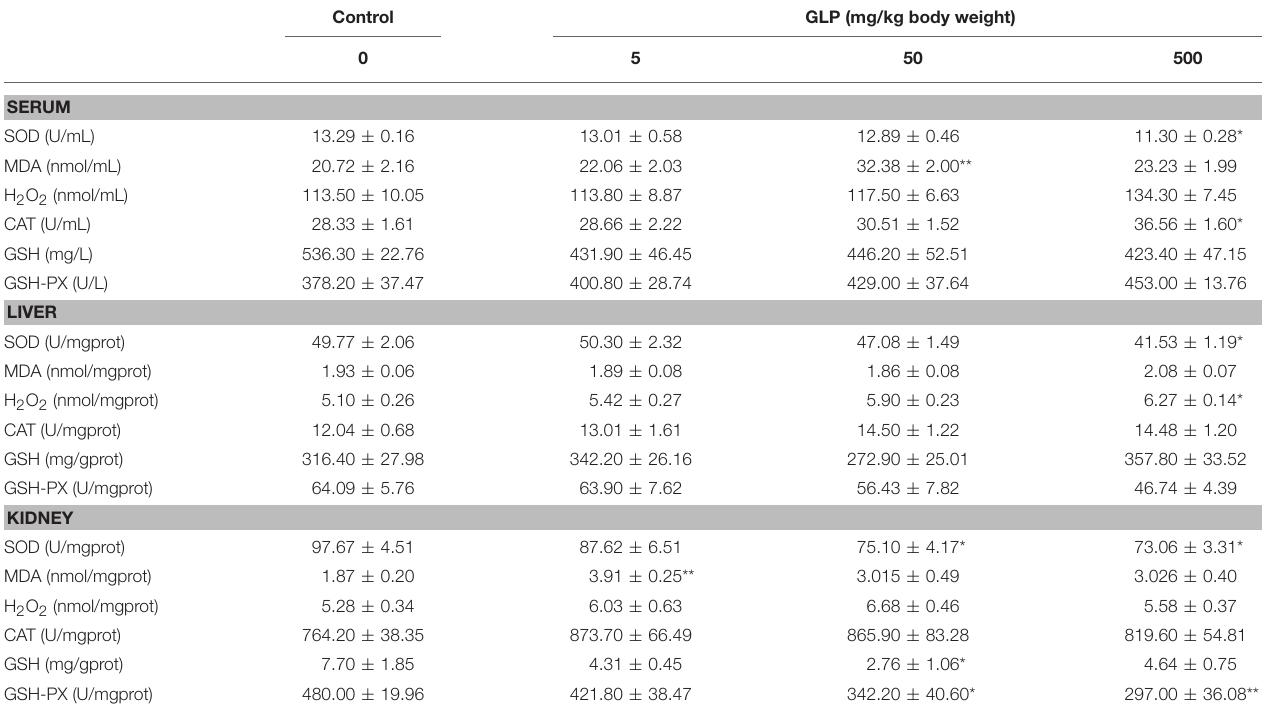
TABLE 3 | Effects of GLP on antioxidant enzyme activities and lipid peroxidation levels in serum, liver, and kidney of rats.